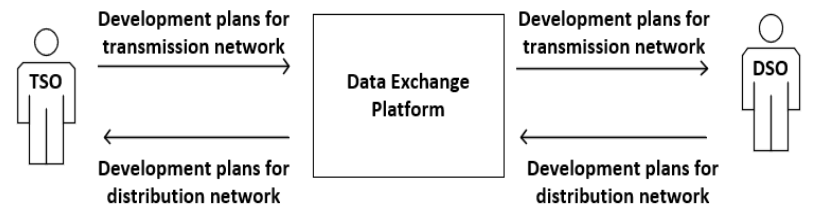
Figure 6. Use case mechanism. Table 1. Comparison table of some key features between blockchain and conventional